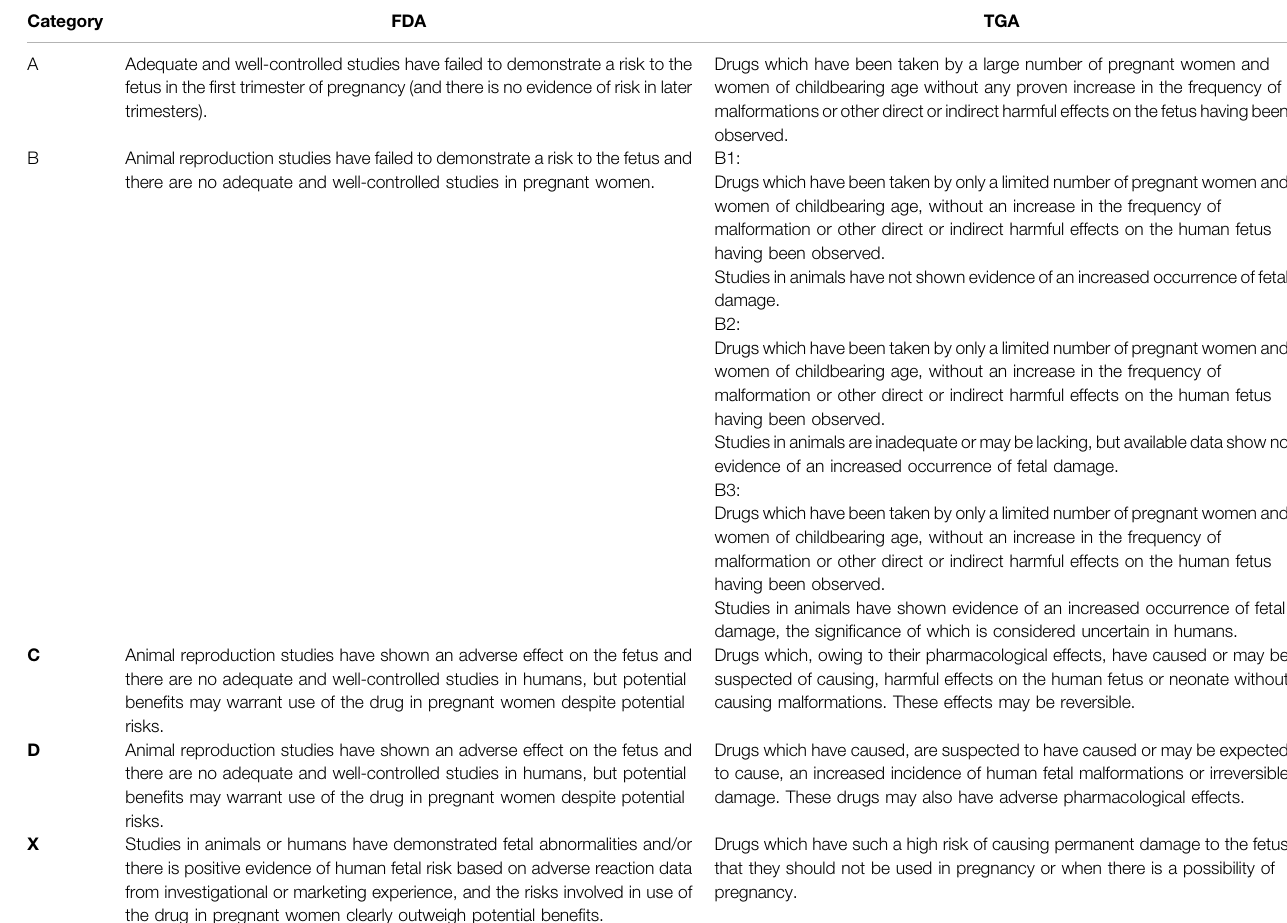
TABLE 2 | Risk categorization by FDA and TGA for use of drugs in pregnancy. Category FDA